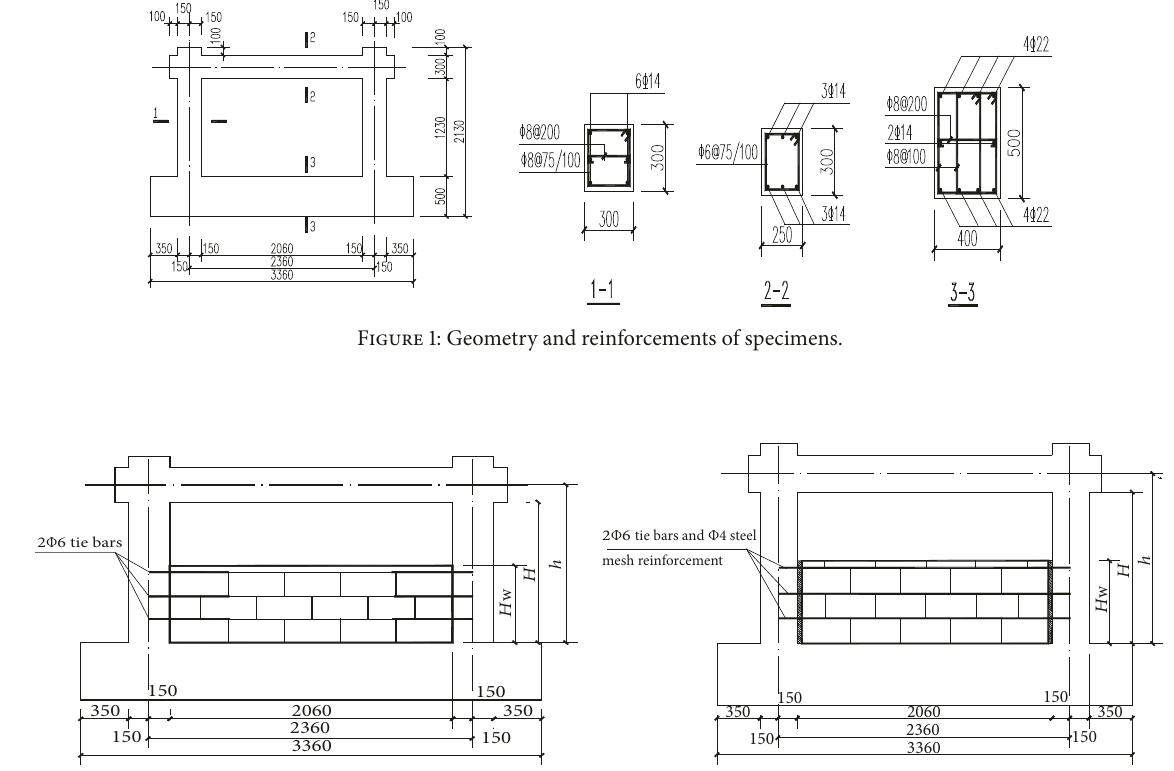
Figure 2: Specimens GWF and RWF.